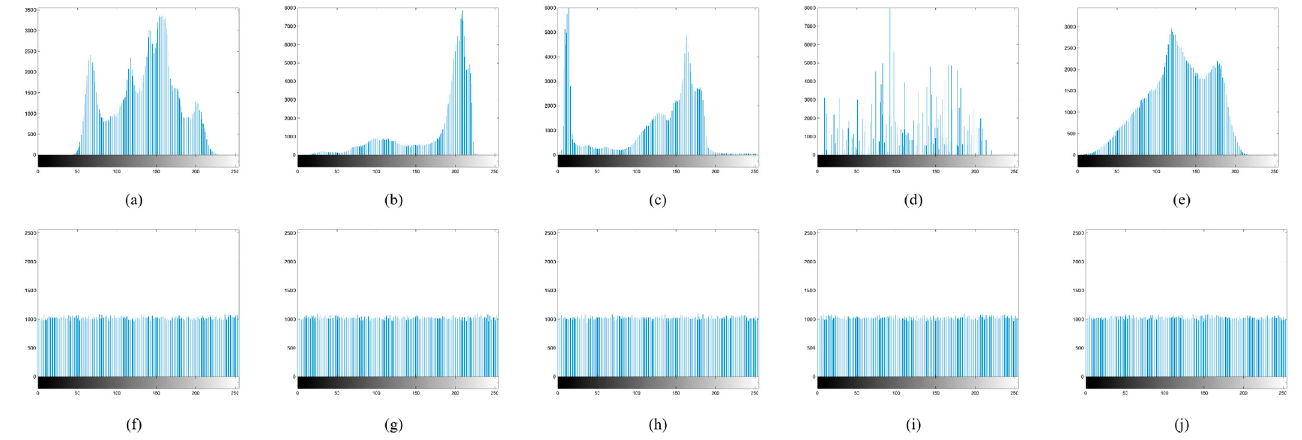
Figure 9. ( a – e ) Histograms of Lena, Airplane, Cameraman, Pepper and Baboon. ( f – j ) Histograms of encrypted images of Lena, Airplane, Cameraman, Pepper and Baboon.